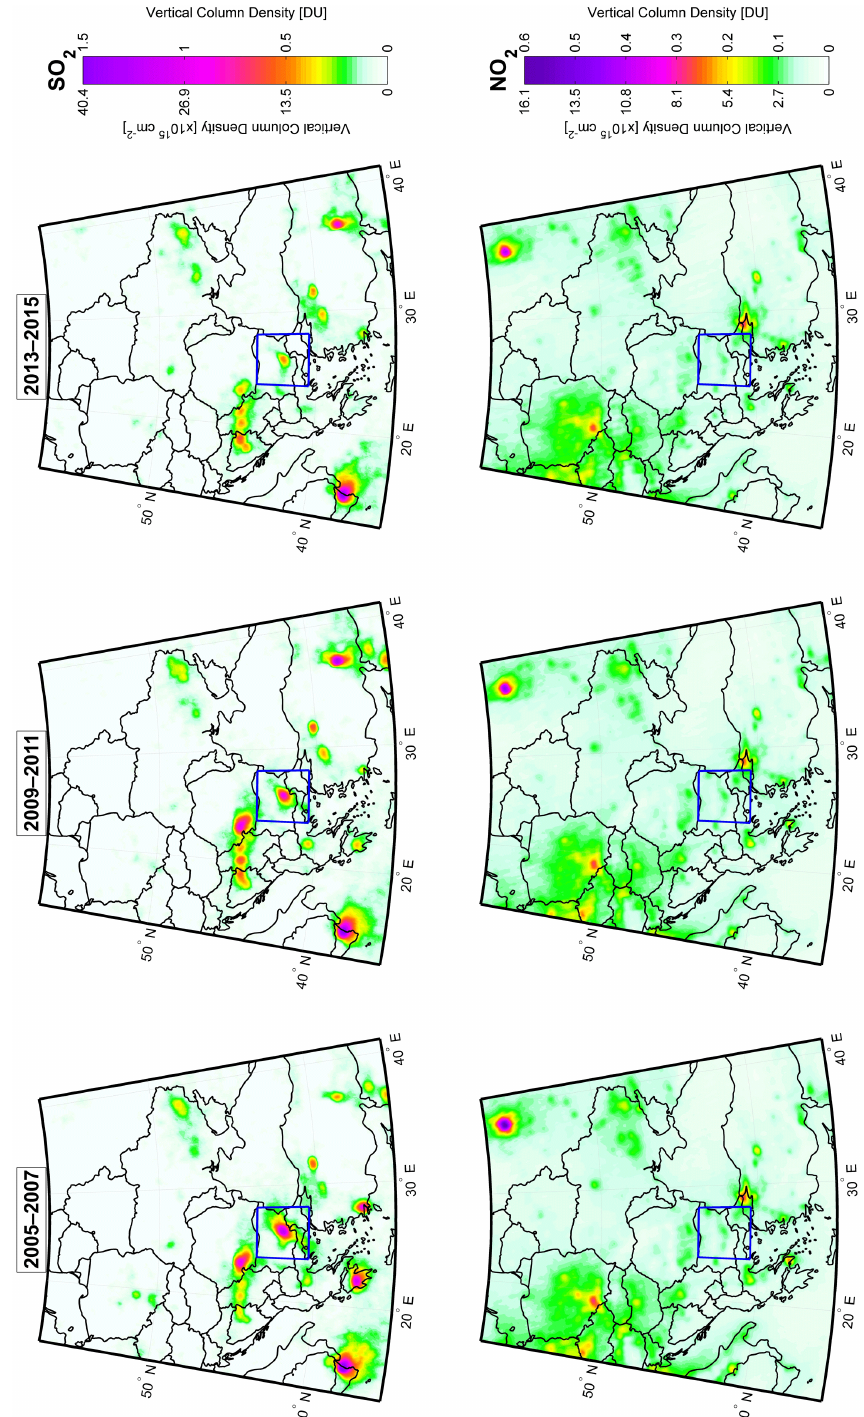
Figure 4. Same as Fig. 2, but for eastern Europe. The largest SO 2 source in the domain is the Etna volcano in Sicily, Italy. The blue box is centered on SO 2 polluted area around Maritsa Iztok coal mining region and the largest coal-fired power plants in southeastern